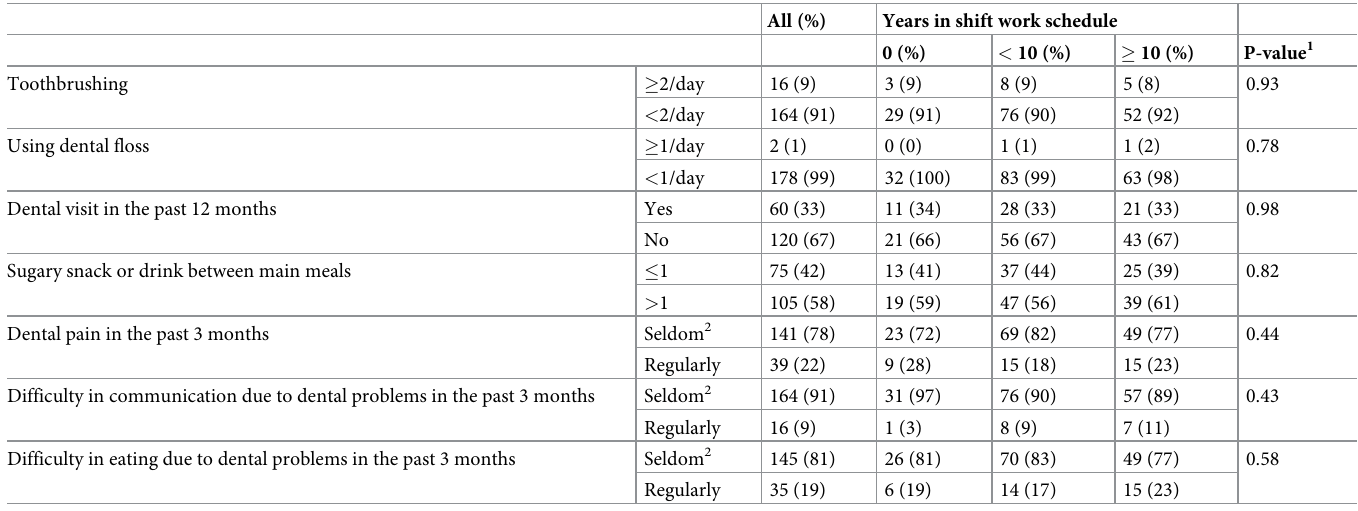
Table 2. Distribution (%) of the workers’ (n = 180) self-reported oral health-related behaviors and quality of life based on their history of shift working.